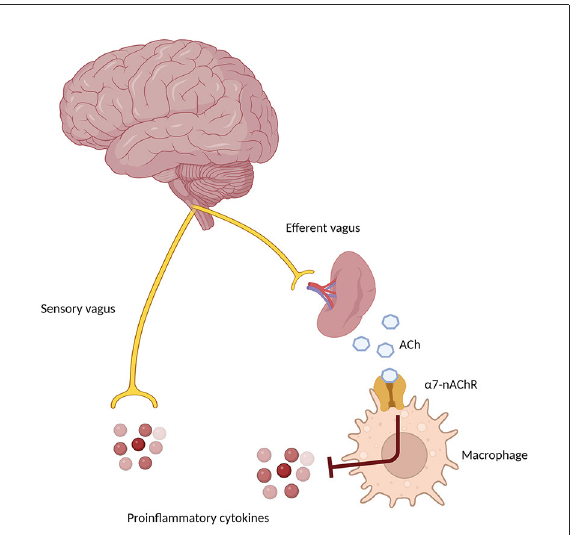
FIGURE3 Schematic representation of the Cholinergic Anti-Inflammatory Pathway (CAIP), showing the afferent arm through the sensory vagus nerve, sensing proinflammatory signals in the periphery, and the efferent anti-inflammatory arm, which through the α 7 nicotinic receptor on peripheral macrophages and immune cells determines a down-regulation of inflammatory